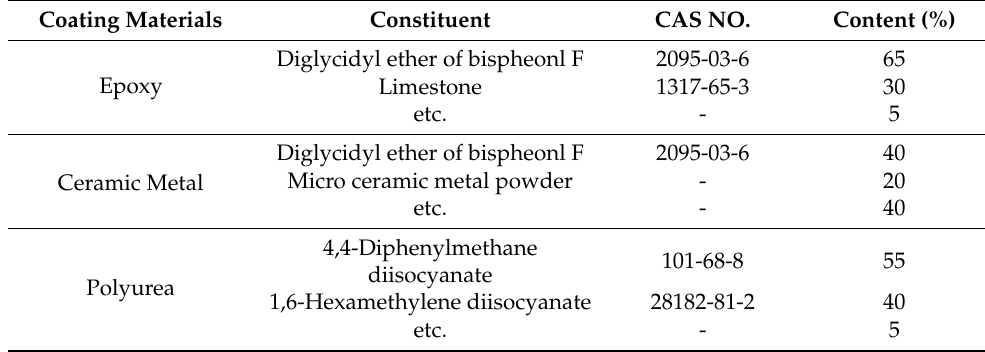
Table 1. Characteristic of coating materials applied to concrete water reservoir